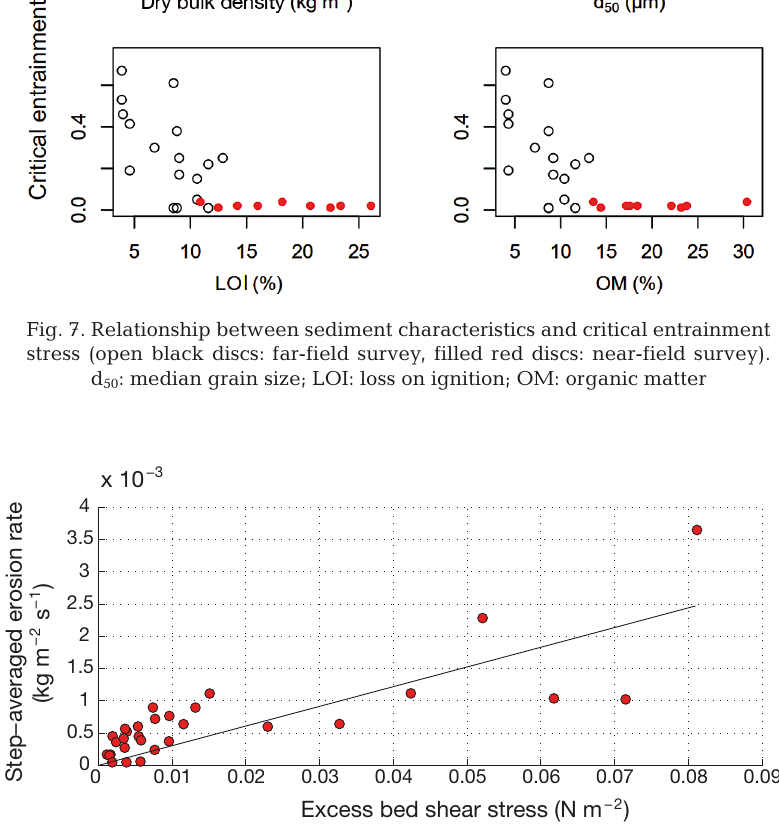
Fig. 8. Excess bed stress ( τ 0 − τ 0,crit ) versus erosion rate ε averaged over each velocity/stress time step on a linear plot